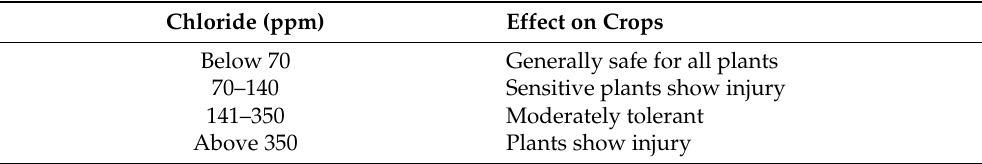
Table 5. Classification based on chloride and its effect on the crops